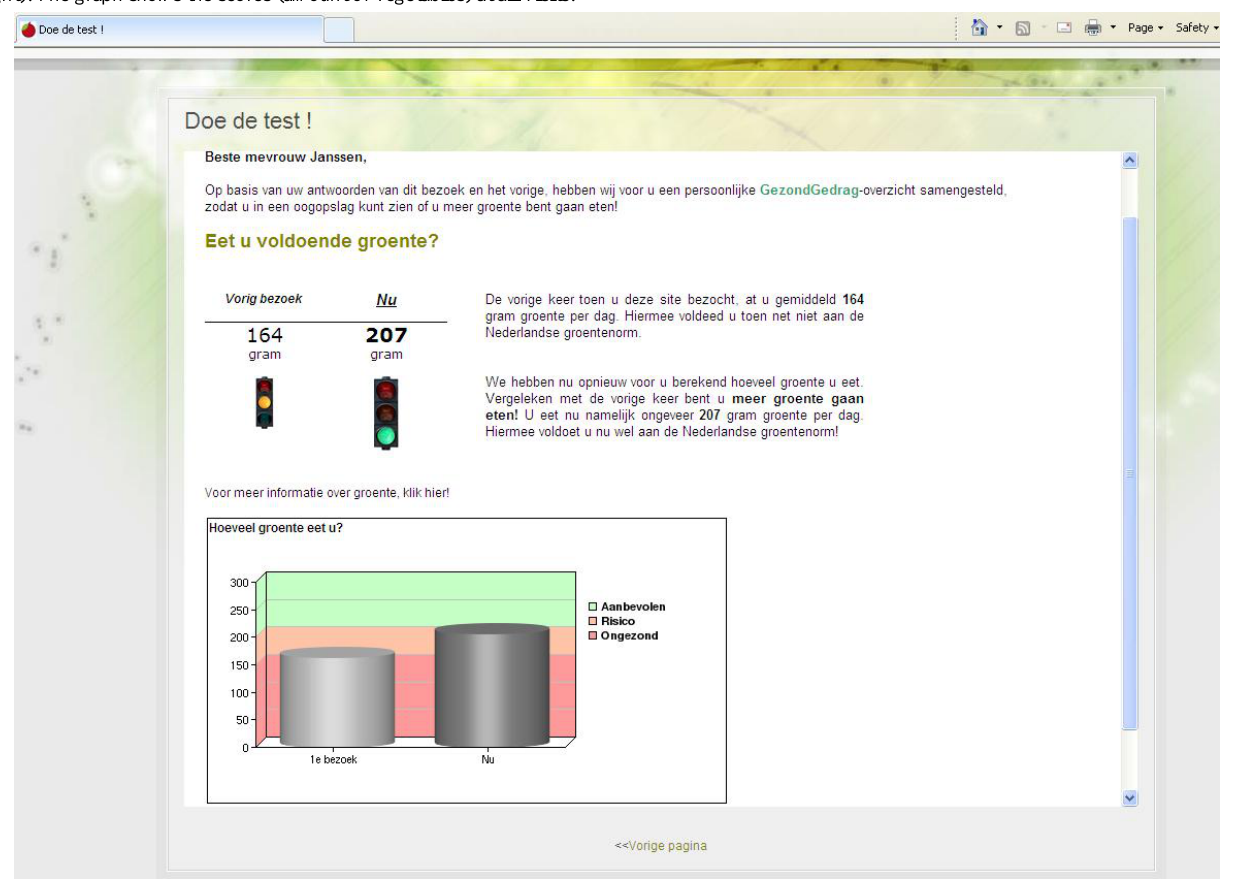
Figure 1. Screenshot of the intervention website showing the vegetable part of the health risk appraisal. The traffic lights show that the respondent did not comply with the vegetable guideline at her first visit (orange traffic light), but that she complied with the guideline at her second visit (green traffic light). The graph shows the scores (amount of vegetables) at all